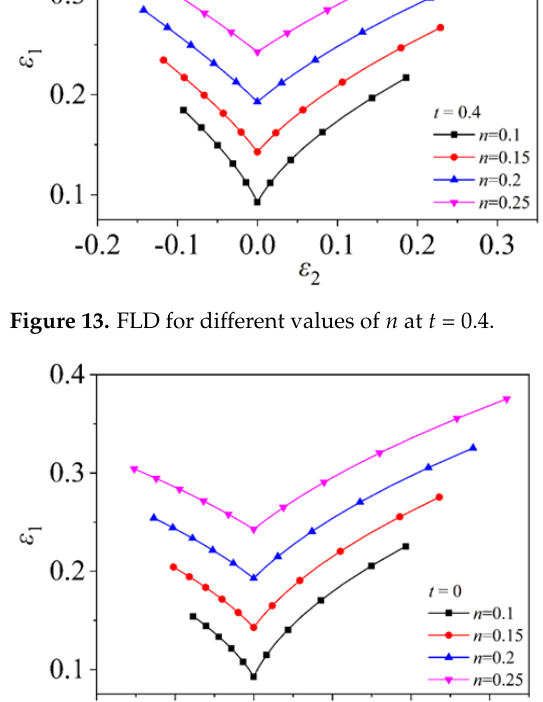
Figure 14. FLD for different values of n at t = 0 0.